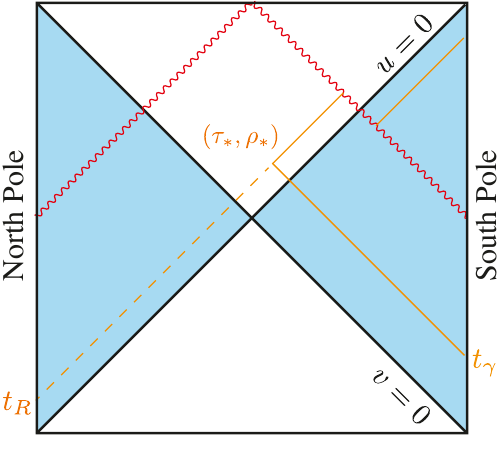
Figure 7 . A message leaving the South Pole is reflected and after crossing the shockwave returns to the